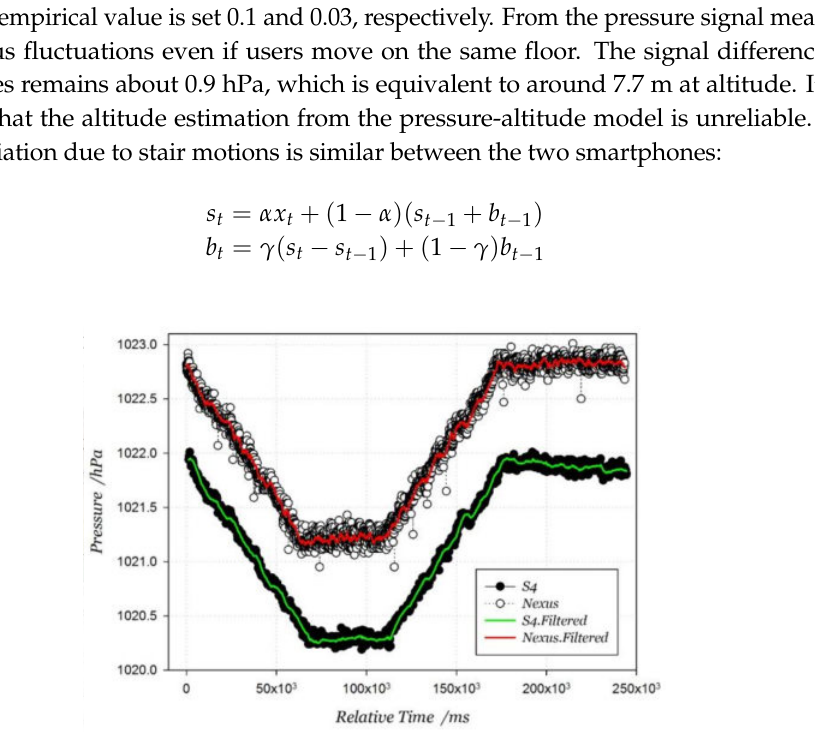
Figure 8. Pressure signals from two smartphones in stair motions.